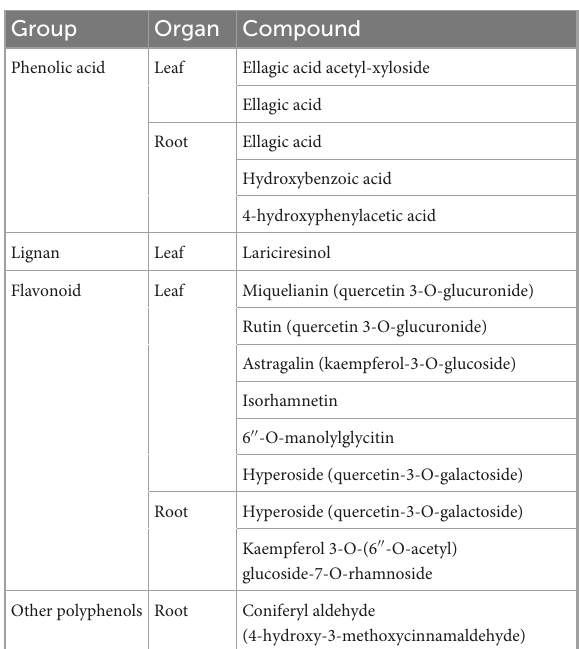
TABLE 3 List of secondary metabolite compounds detected, identified, and quantified in leaves and roots of 6-month-old Castanea sativa seedlings.